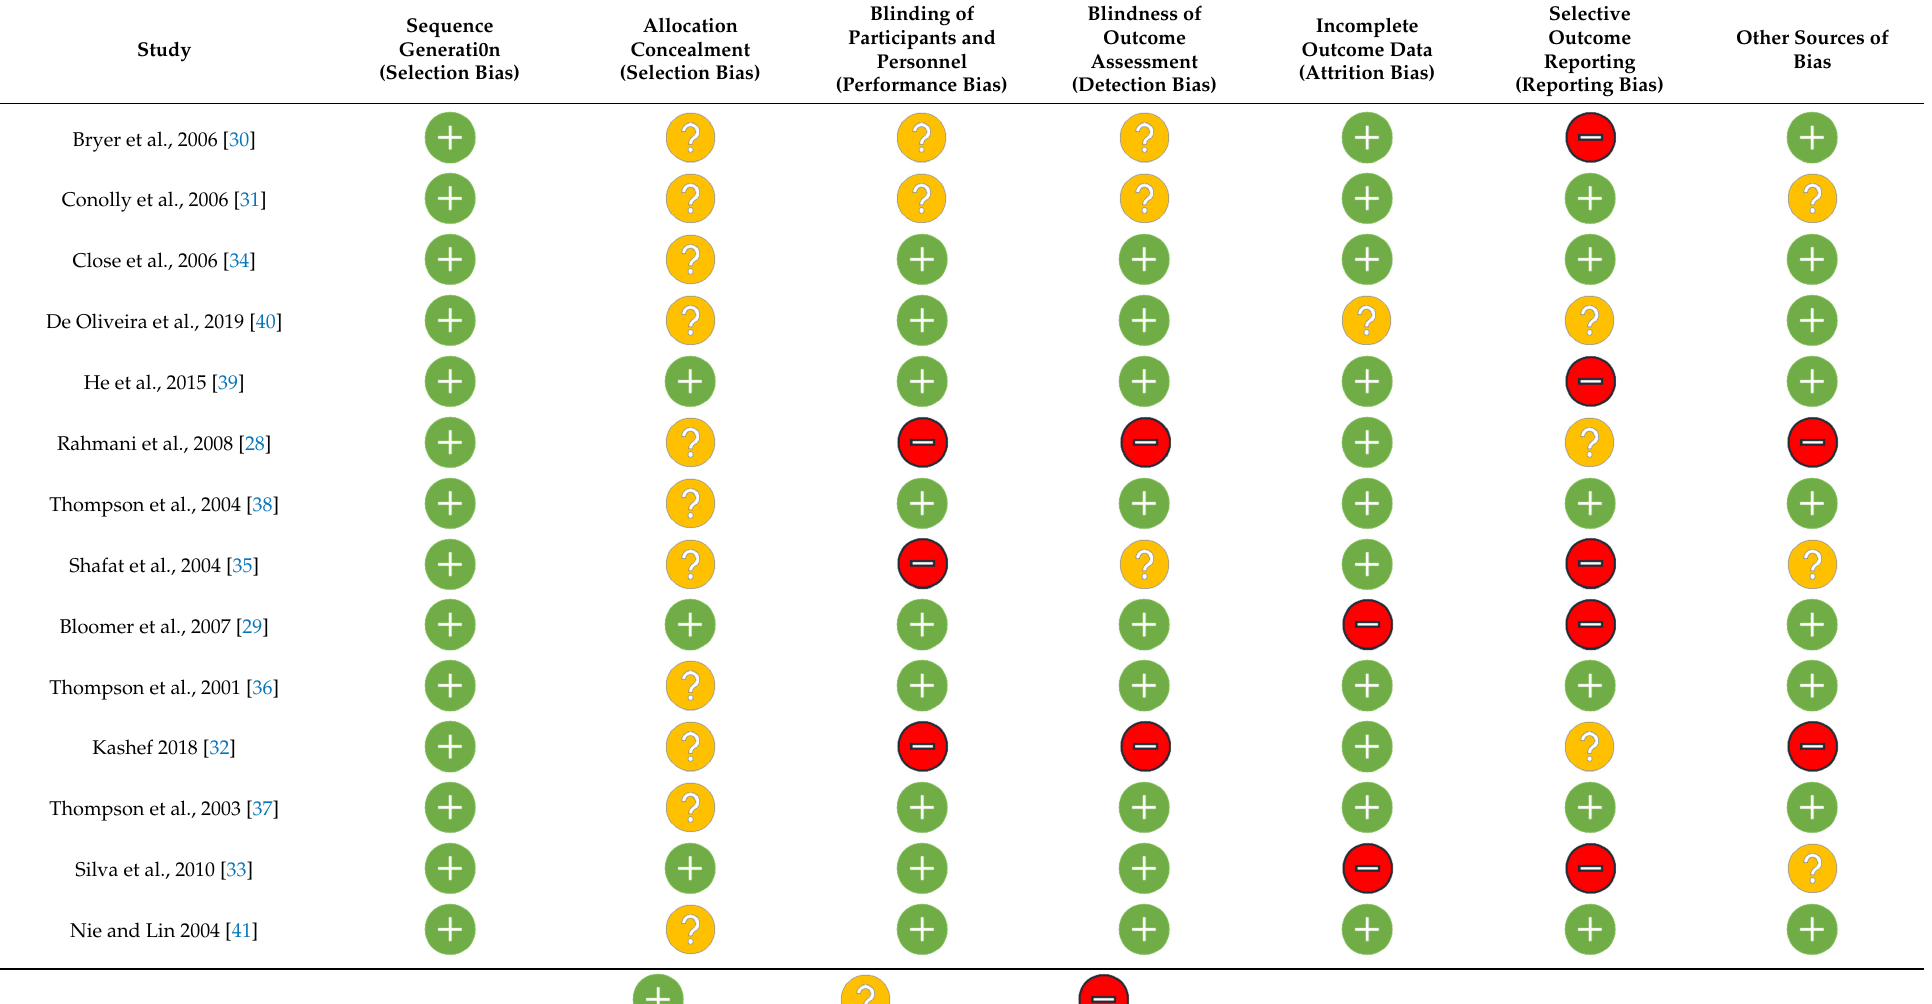
Table 1. Risk of bias.